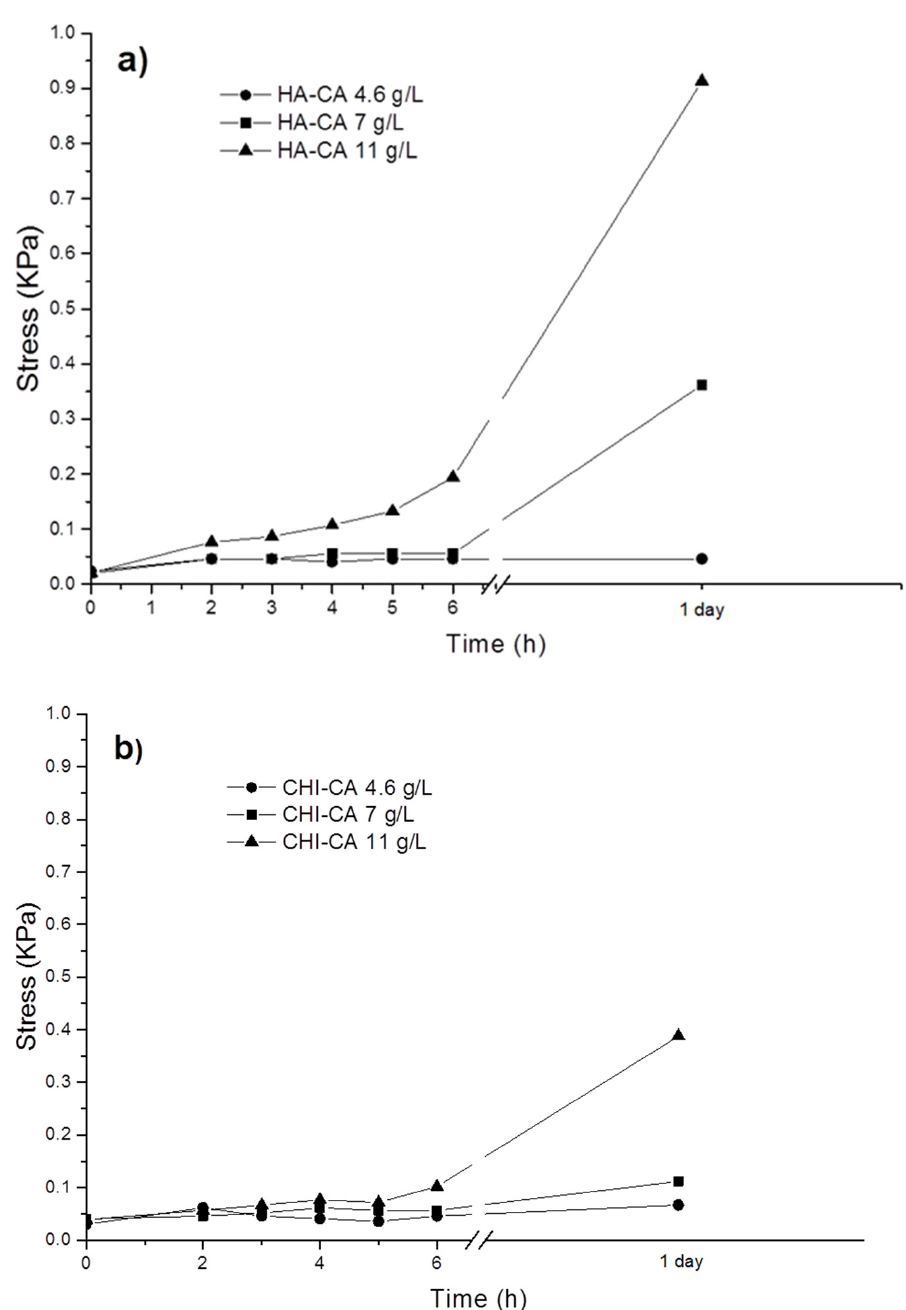
Figure 9. Skin adhesion graph of ( a ) HA-CA and ( b ) CHI-CA over time at different concentra- tions.